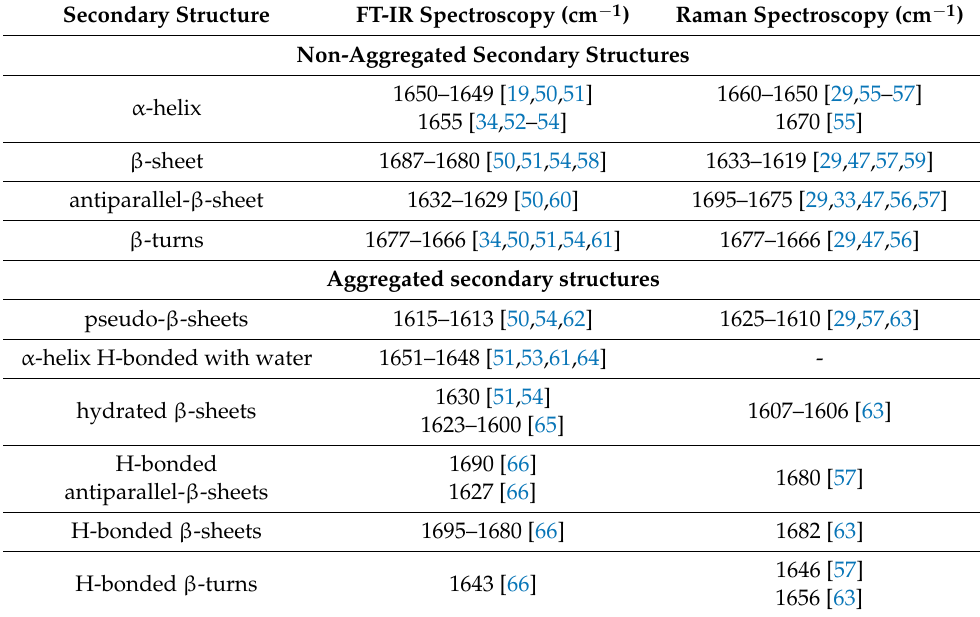
Table 2. Assignments of particular secondary structures in the amide I band for FT-IR and Raman